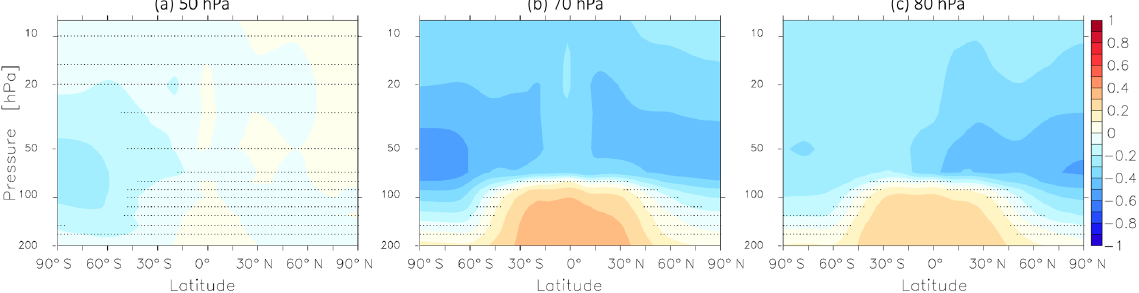
Figure 5. As Fig. 4 but for the correlation between AoA and tropical upwelling. The stippled regions mark where the correlation is not significant on the 95% confidence level.